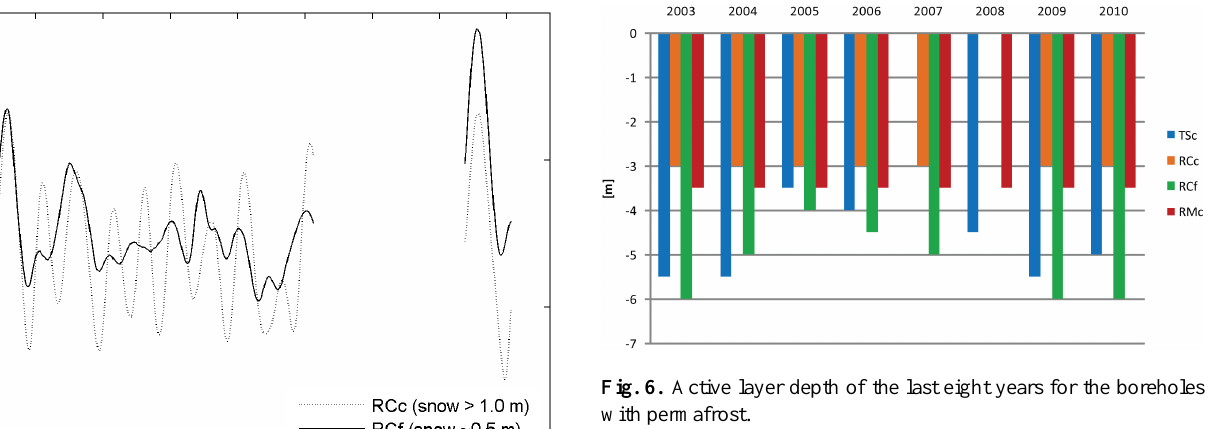
Fig. 6. Active layer depth of the last eight years for the boreholes with permafrost.